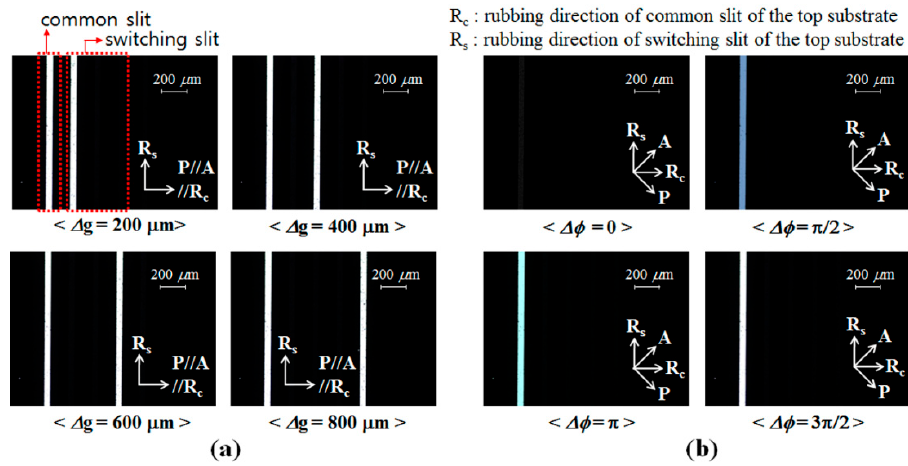
Figure 9. POM images depending on applied voltage conditions at each slit. ( a ) POM images measured between the parallel polarizers with varying selected switching slits for interference, which creates fringe patterns with four different spatial frequencies; ( b ) POM images showing the four-step phase shifting of the LC layer on the common slit captured between the crossed polarizers to show field-dependent birefringence variation.